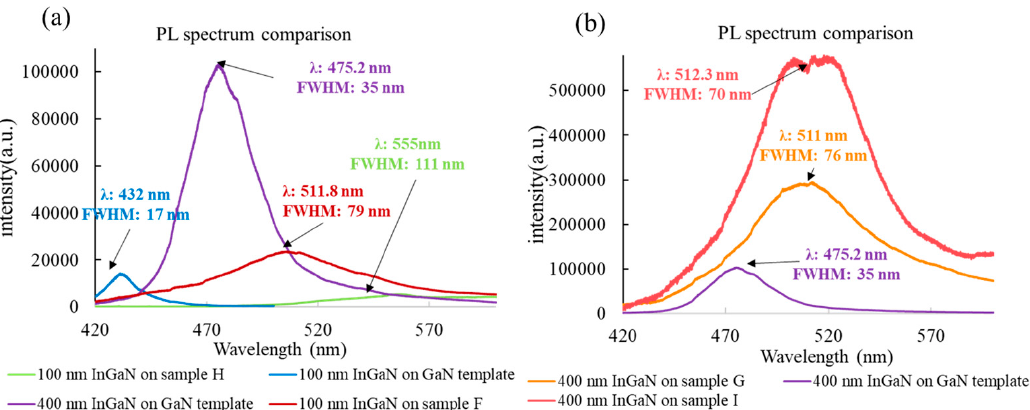
Figure 5. PL spectrum of ( a ) 100 nm InGaN on SAM and GaN template with an intensity range of 0 to ~100,000. ( b ) 400 nm InGaN on SAM and GaN template with an intensity range of 0 to ~600,000 (400 nm InGaN on GaN template was the common spectrum for both plots).